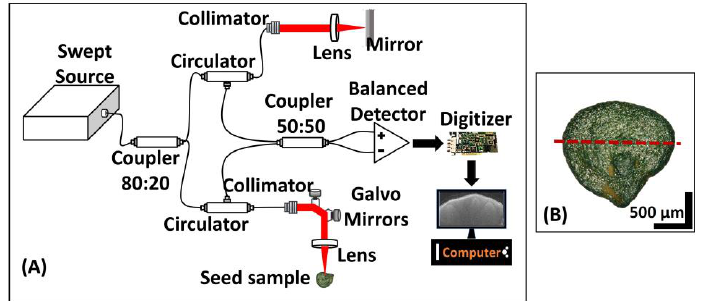
Figure 1. Schematic of the SS-OCT setup. ( A ) Schematic of the SS-OCT system. ( B ) Photograph of a sample Capsicum annuum seed. The dashed line represents the place of OCT scanning beam.